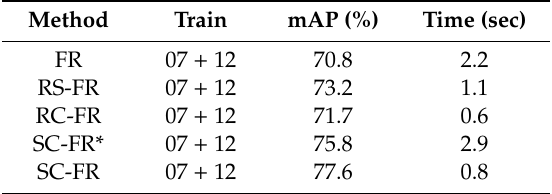
Table 3. Main performance parameters in ablation process of SC-Faster